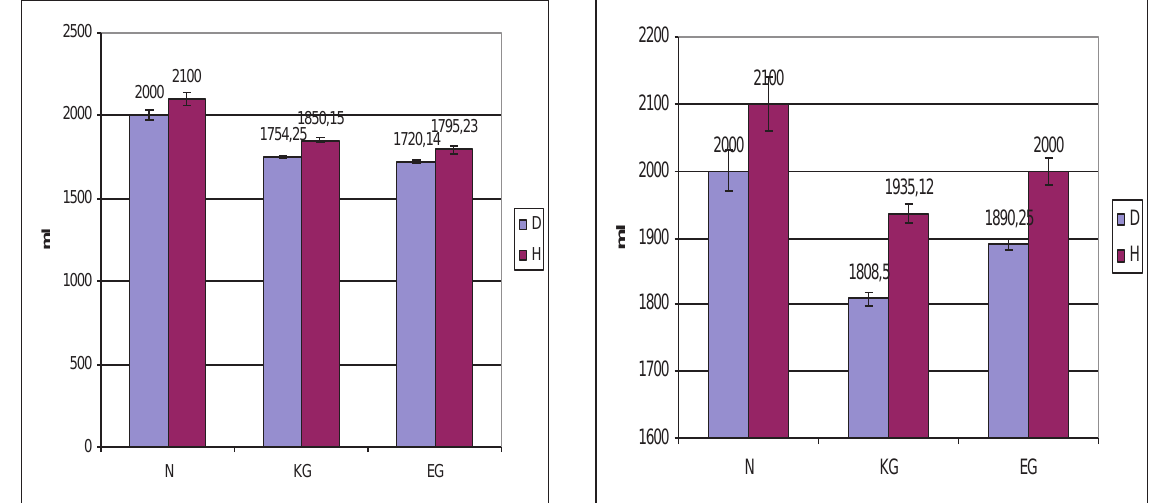
Fig. 1. The magnitude of the vital capacity of the lungs in children aged 12-13 years at the beginning (A) and at the end (B) of the study (n=40): D – girls, H – boys, N – norm, KG – control group, EG – experimental group, ml –